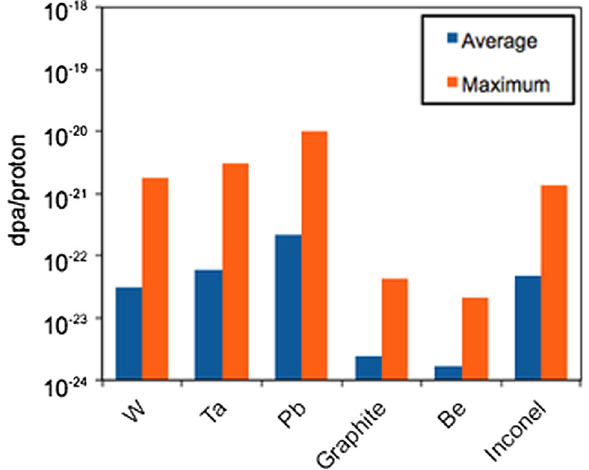
FIG. 4 (color online). DPA values per incident proton of 800 MeV kinetic energy for different target